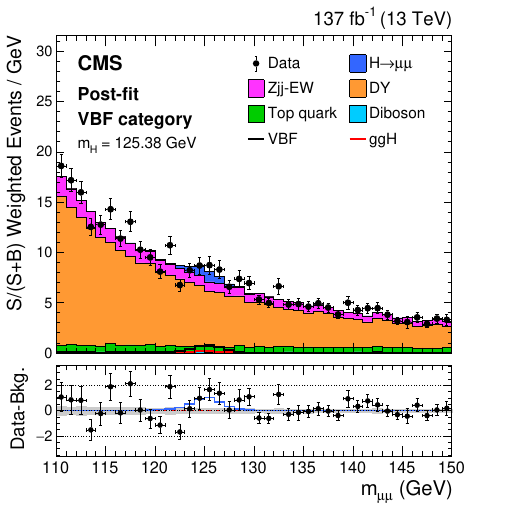
Figure 12 . Left: the m distribution for the weighted combination of VBF-SB and VBF-SR µµ events. Each event is weighted proportionally to the S/(S+B) ratio, calculated as a function of the mass-decorrelated DNN output. The lower panel shows the residuals after subtracting the background prediction from the S+B fit. The best fit H → µ + µ − signal contribution is indicated by the blue line and histogram, while the grey band indicates the total background uncertainty from the background-only fit. Right: the m distribution for the weighted combination of all µµ event categories. The lower panel shows the residuals after background subtraction, with the best fit SM H → µ + µ − signal contribution for m = 125 . 38 GeV indicated by the red line. H B (H → µ + µ − ) are correlated across the 7, 8, and 13 TeV analyses. Experimental